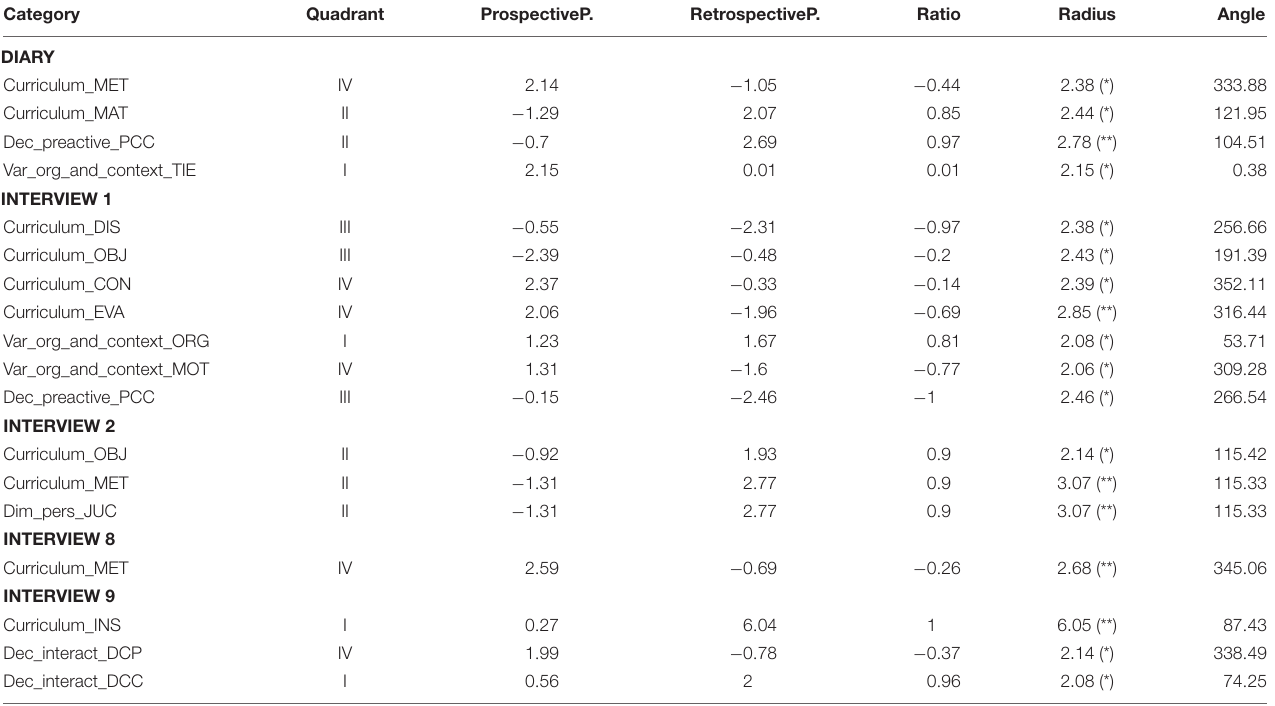
TABLE 2 | Polar coordinate analysis results for the relationship between the focal category TAR and Joseph’s diary and interviews.